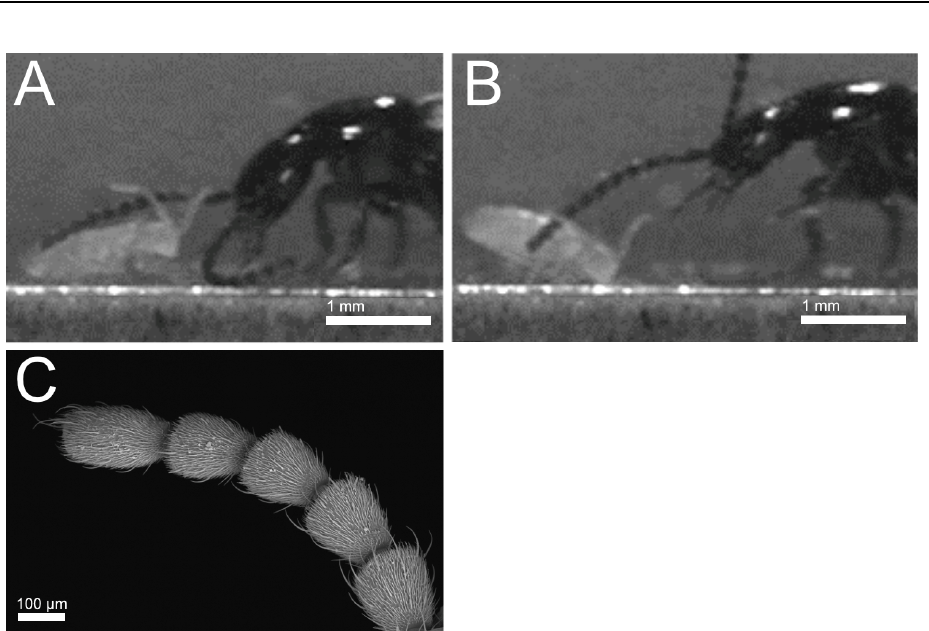
Figure 16. Philonthus varians . Subliminal touching of a Heteromurus nitidus springtail by thin setae on the antennae of the beetle, but without triggering the springtail’s escape response (lateral view, A , B ). SEM view of antenna ( C ) .